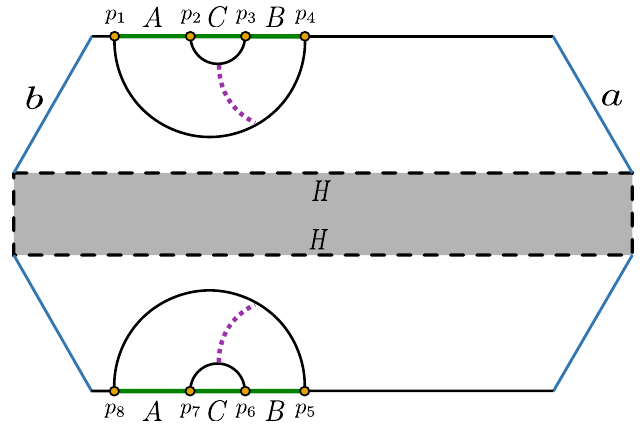
Figure 25 . The endpoints of the intervals A and B in the two BCFT 2 copies are identified as p 1 = p 8 = r I + (cid:15) , p 2 = p 7 = r 2 , p 3 = p 6 = r 3 and p 4 = p 5 = r 4